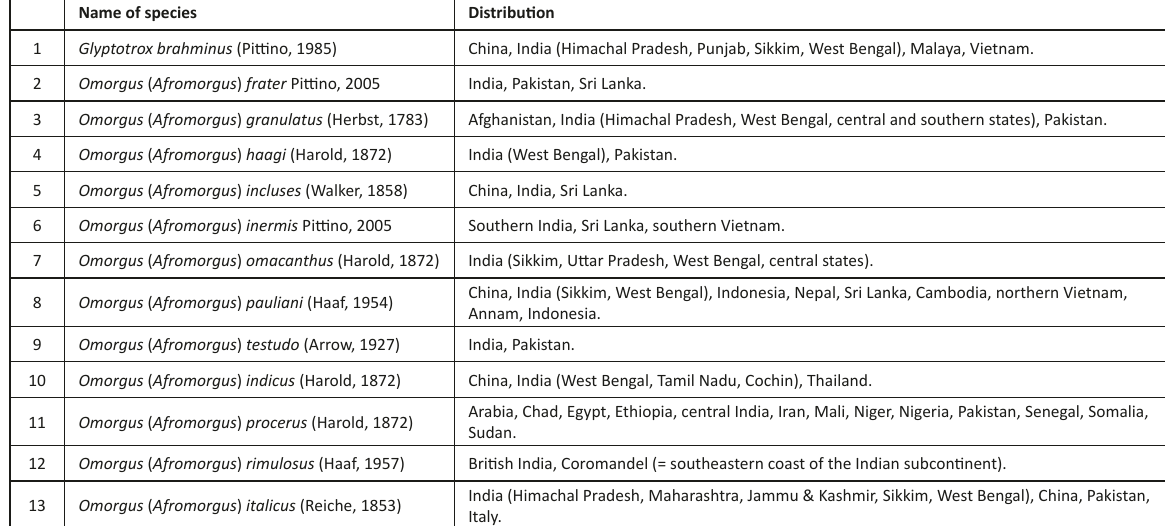
Table 1. List of species from Trogidae family reported from India (Adopted from Zidek (2013, 2017). Name of species